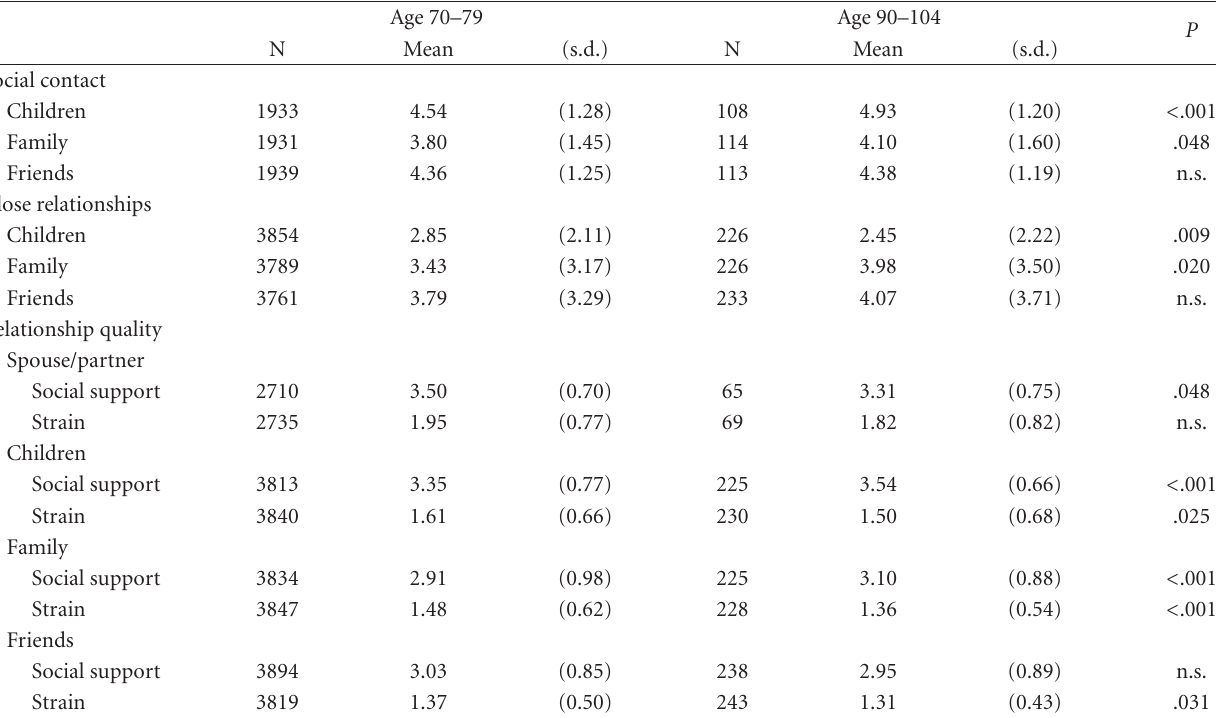
Table 2: Age di ff erences in social relationships between the old (age 70–79) and the oldest-old (age 90–104), HRS 2006/2008.